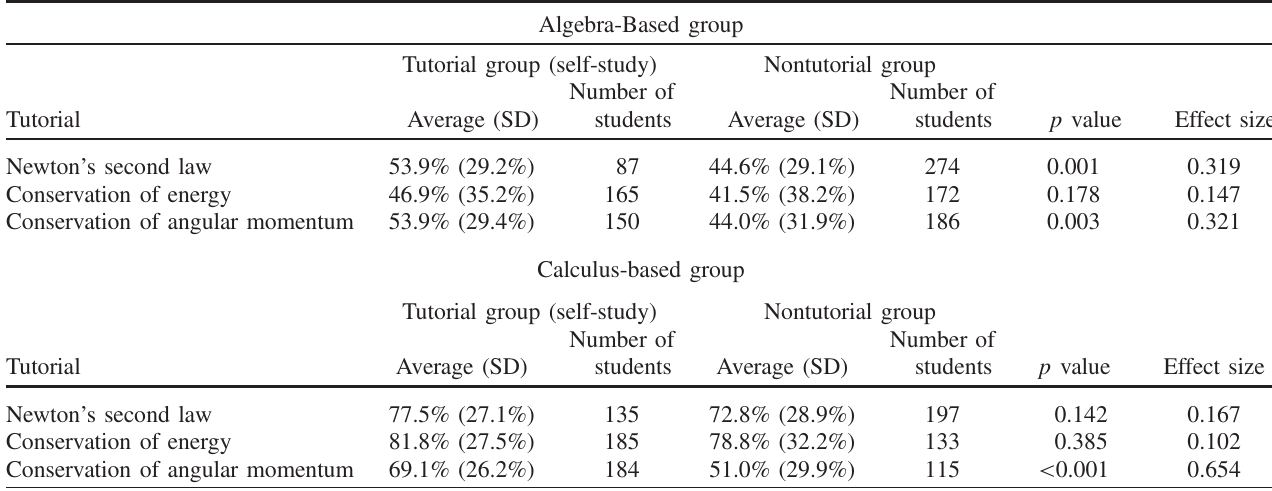
TABLE III. Comparison of the performance on the paired problem and standard deviations for students who used the tutorials as a self-study tool and those who did not use them in large, brick-and-mortar introductory physics courses.